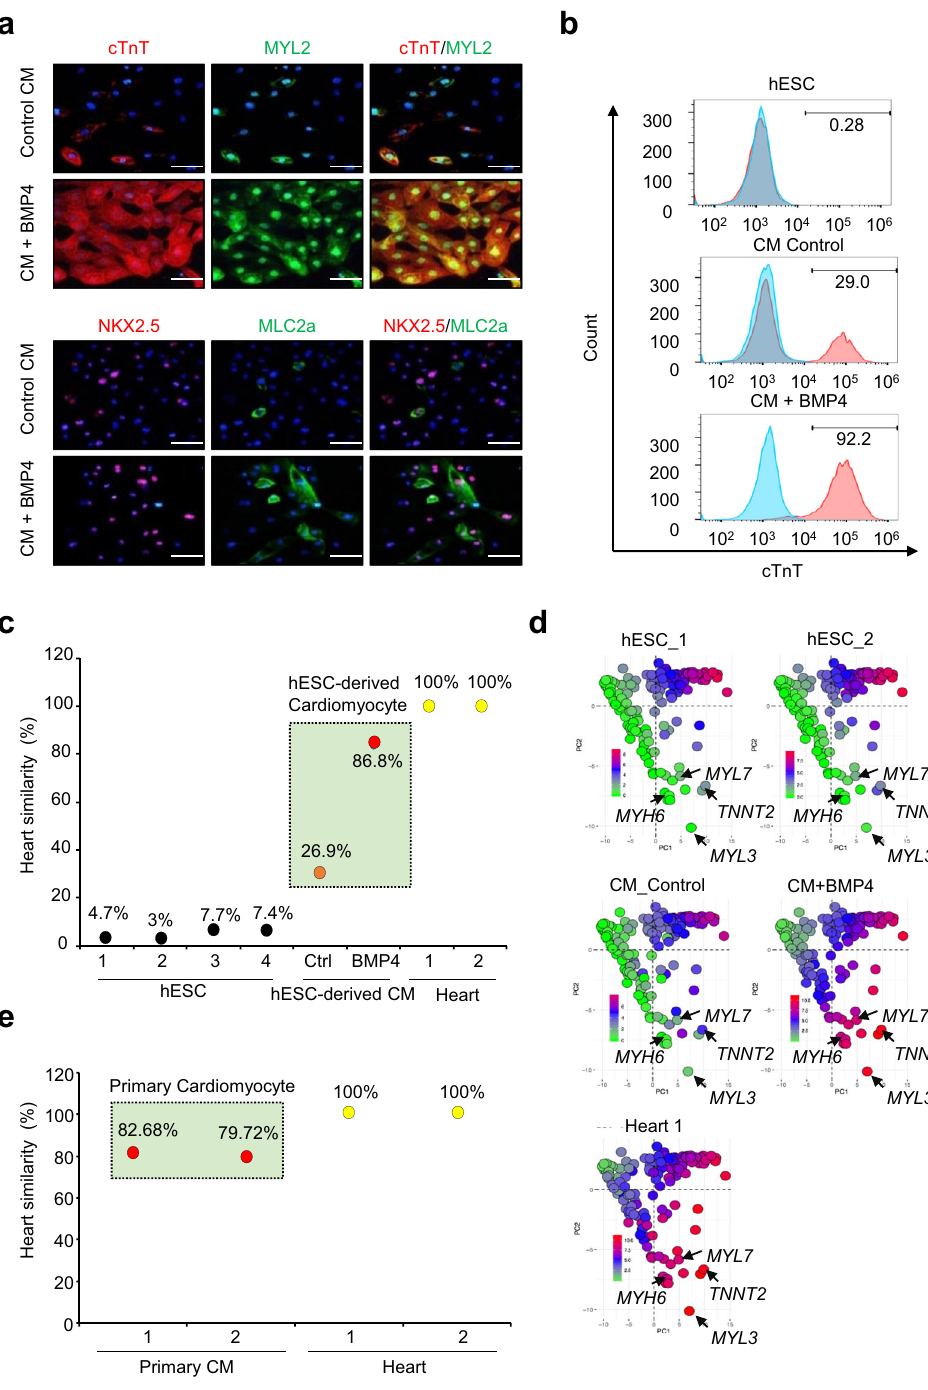
Fig. 5 Quantitative similarity of hESC-derived CMs to heart tissue using HtGEP analysis. a Immuno fl uorescence staining images of hESC-derived CMs ( n = 3) and CMs + BMP4 ( n = 3). Anti-cTnT and anti-NKX2.5 antibodies (Alexa Fluor 594; red), anti-MYL2 and anti-MLC2a antibodies (Alexa Fluor 488; green), and DAPI (blue) were used. Scale bar, 50 μ m. b FACS analysis using cardiac muscle-speci fi c markers (cardiac troponin T, cTnT) within live cells (gated by forward and side scatter). The number indicates the differentiation rate of the hESC-derived CMs and CMs + BMP4. c The result of the HtGEP algorithm for hESC-derived CMs and human heart tissue. d GEAP analysis of the HtGEP results. Different colors indicate the gene expression levels from HtGEP in hESC-derived CMs (green; 0, red; 10). e The result of the HtGEP algorithm with primary CM